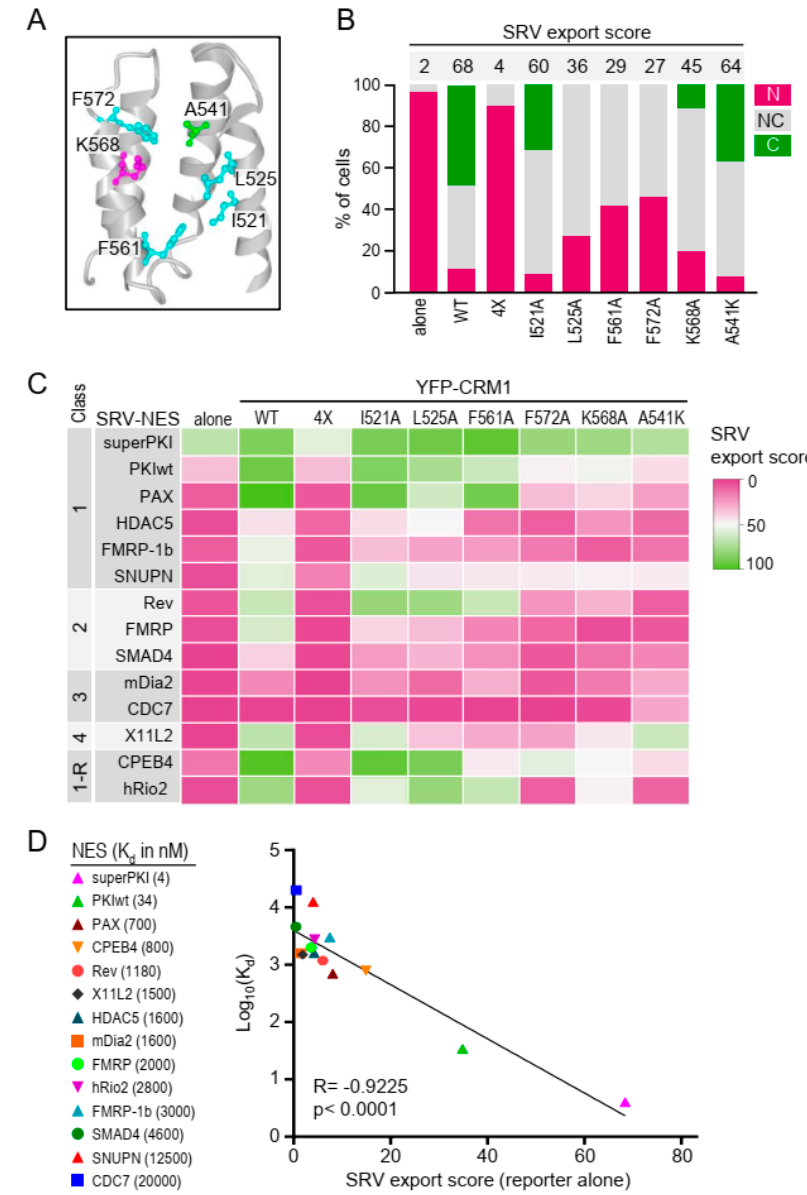
Figure 3. Using the SRV B/A assay to test the effect of single-residue mutations in CRM1 NES-binding groove. ( A ) View of CRM1 NES-binding groove generated with NCBI iCn3D viewer from PDB structure 3GJX [15]. The residues individually mutated in this study are highlighted using ball and stick representation, while the remaining residues are represented using ribbon style. ( B ) Graph shows an example of the results of SRV B/A assays testing export activity of the different YFP-CRM1 mutants against a reporter containing one of the previously characterized NES motifs (in this case SRV-X11L2). The localization of the reporter was determined in at least 200 cells per sample. Bar colors represent the percentage of cells showing the indicated reporter localization (N, NC or C). The number above each bar indicates the corresponding “SRV export score”, derived as described in Methods section. ( C ) Heat map summarizing the results obtained with the 14 reporters (graphs for each reporter are provided in Supplementary Figure S2). The color indicates the SRV export score for each NES/variant combination, ranging from 0 (no export) to 100 (full export). ( D ) Graph showing the correlation between the previously reported CRM1 binding affinity (expressed as Log 10 (K d )) of each NES peptide [31] and the SRV export score of the corresponding reporter, when expressed alone. Pearson correlation coefficient and p value are indicated.